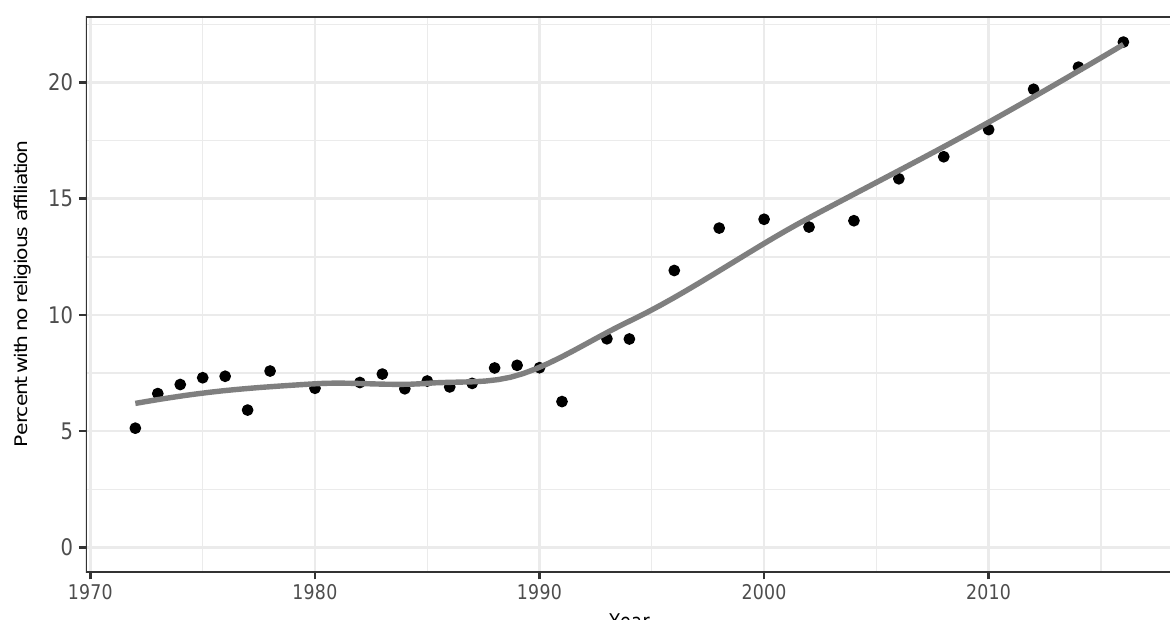
Figure1: Percentage of respondents in the General Social Survey with no religious affiliation by year. Smoothed trend is shown in grey. All percentages are sample